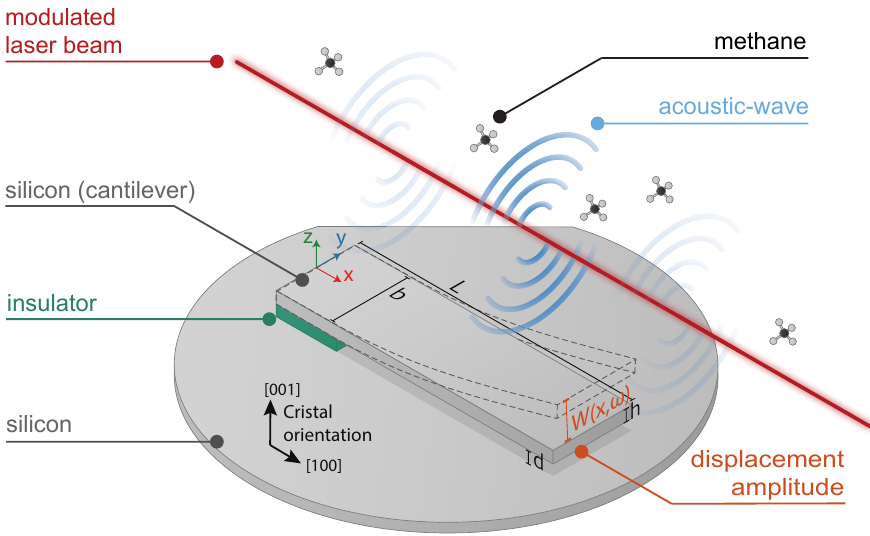
Figure 1. Sensing scheme of a silicon cantilever-based sensor for photoacoustic gas detection with capacitive transduction